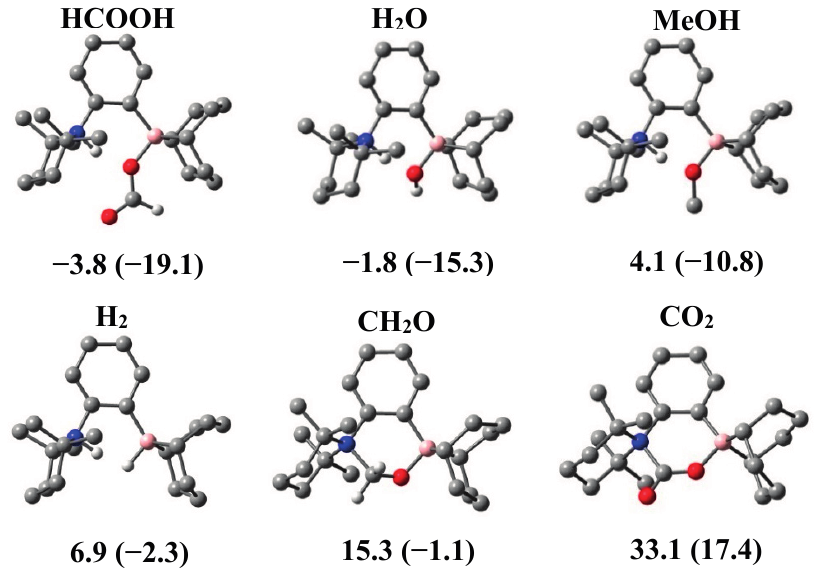
Figure 3. DFT calculations at ω B97XD/6-31++G** level of theory of the adducts of 1 with various small molecules. The Δ G ( Δ H) values in kcal·mol − 1